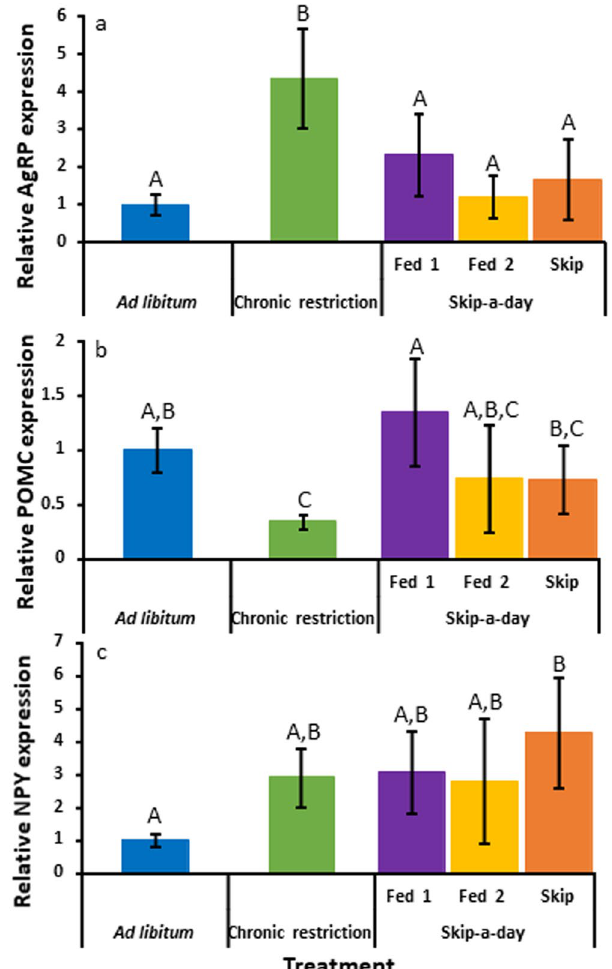
Figure 2. Gene expression of agouti-related peptide (AgRP) ( a ), pro-opiomelanocortin (POMC) ( b ) and neuropeptide Y (NPY) ( c ) in the arcuate nuclei of Red Junglefowl chicks reared under ad libitum feeding (blue, N = 6), chronic feed restriction (Green, N = 6) and skip-a-day feeding consisting of a first fed day, Fed 1 (purple, N = 5) a second fed day, Fed 2 (yellow, N = 4) and a skipped day without food (orange, N = 7). Expression levels represent mRNA levels relative to those of the housekeeping gene, GAPDH. Error bars represent standard deviations of the mean. Significant differences (determined using two-way ANOVA, p < 0.05) are indicated with different